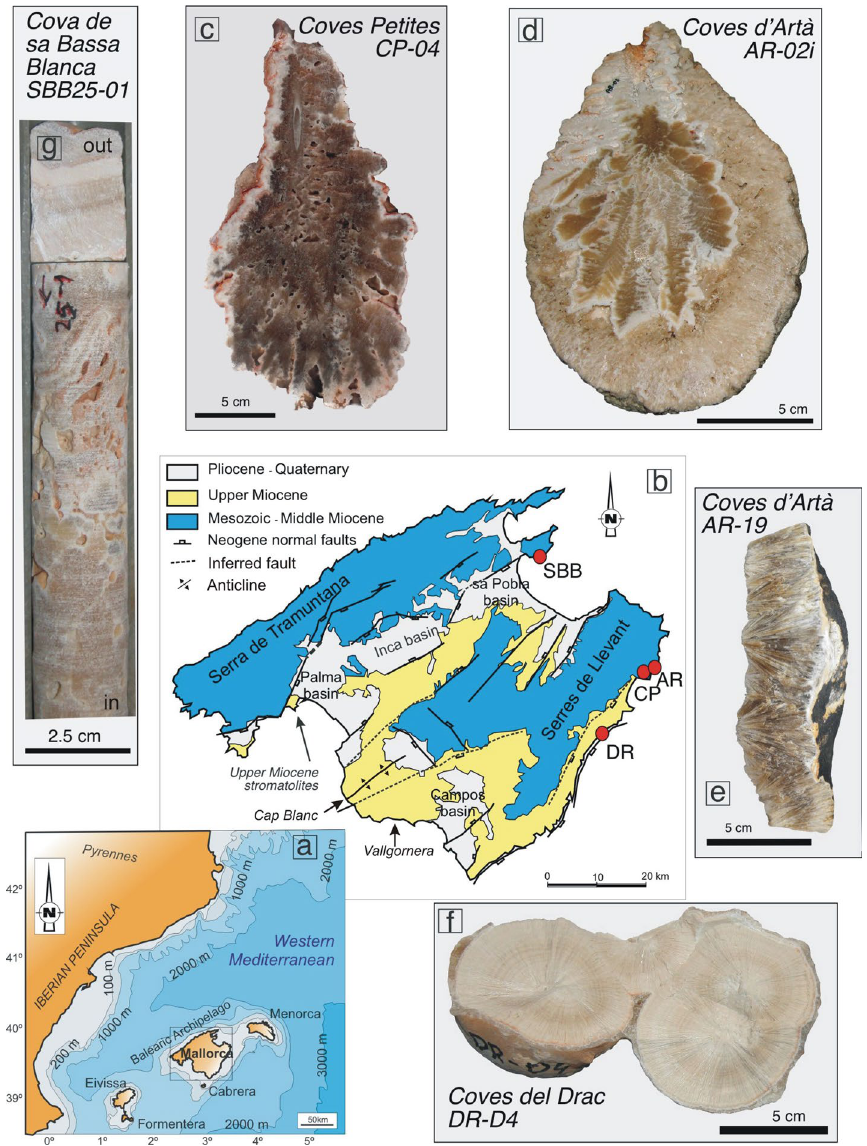
Figure 1. Sites location and samples. ( a ) Map of Mallorca in the western Mediterranean (gray rectangle). ( b ) Location of caves sampled for POS (red solid dots). ( c-g ) Cross-section of the investigated POS: ( c ) CP-04, ( d ) AR-02i, ( e ) AR-19, ( f ) DR-D4v, and ( g ) SBB25-01. Maps ( a , b ) are available under CC Public Domain License from https ://pixab ay.com/illus trati ons/map-europ e-world -earth -conti nent-26726 39/ and https ://pixab ay.com/illus trati ons/mallo rca- map-land-count ry-europ e-96836 3/, respectively, on which the bathymetry and geology were